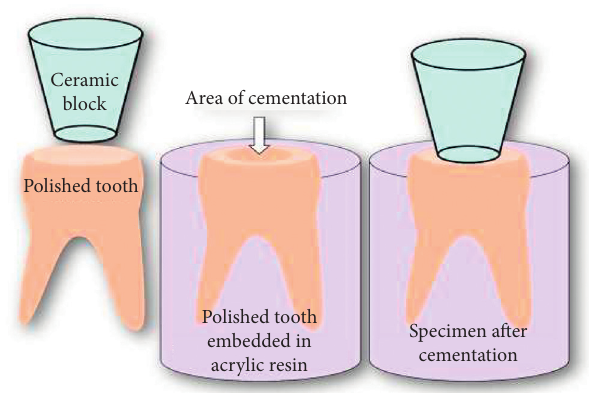
Figure 1: Schematic illustration of specimen preparation (dentin, resin cement, and